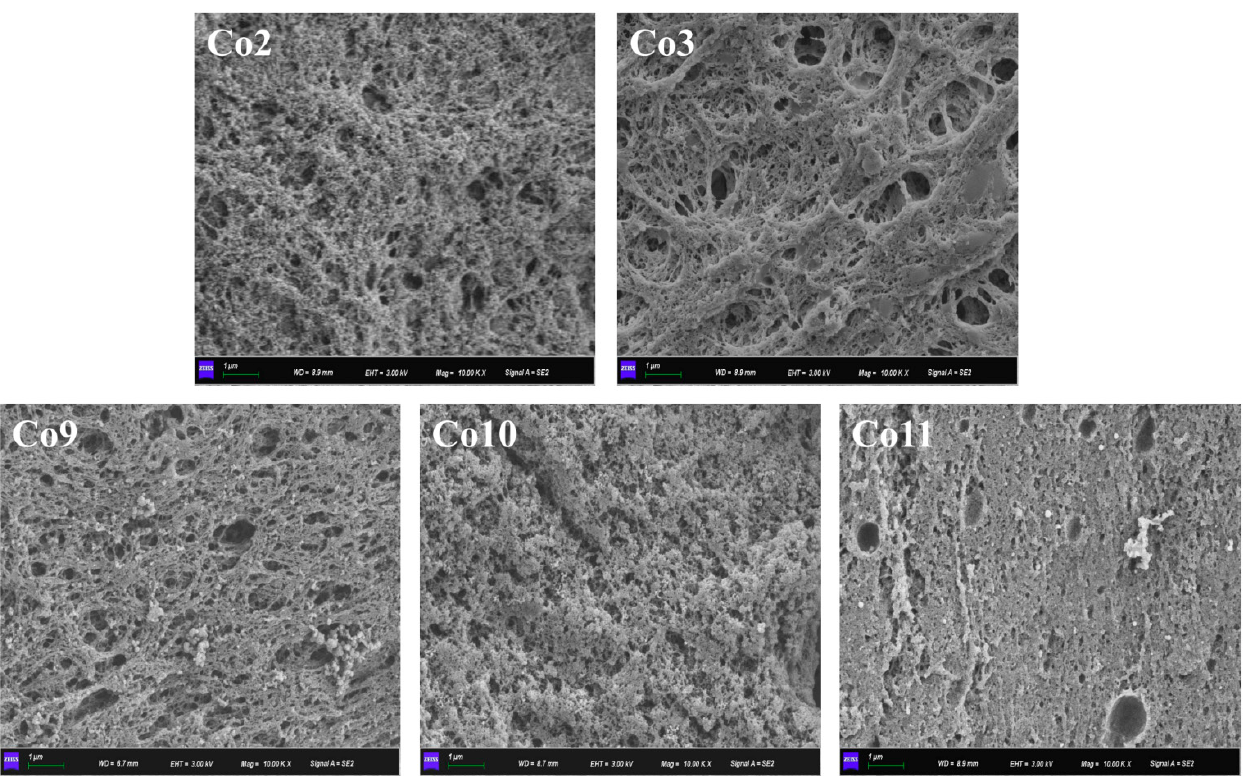
Figure 9. Texture properties of heat-induced gel of Co prepared under different extraction pH con- ditions. Note: Hardness of different samples with different capital letters has a significant difference ( p < 0.05), and the springiness of different samples with different lowercase letters has a significant difference ( p < 0.05).